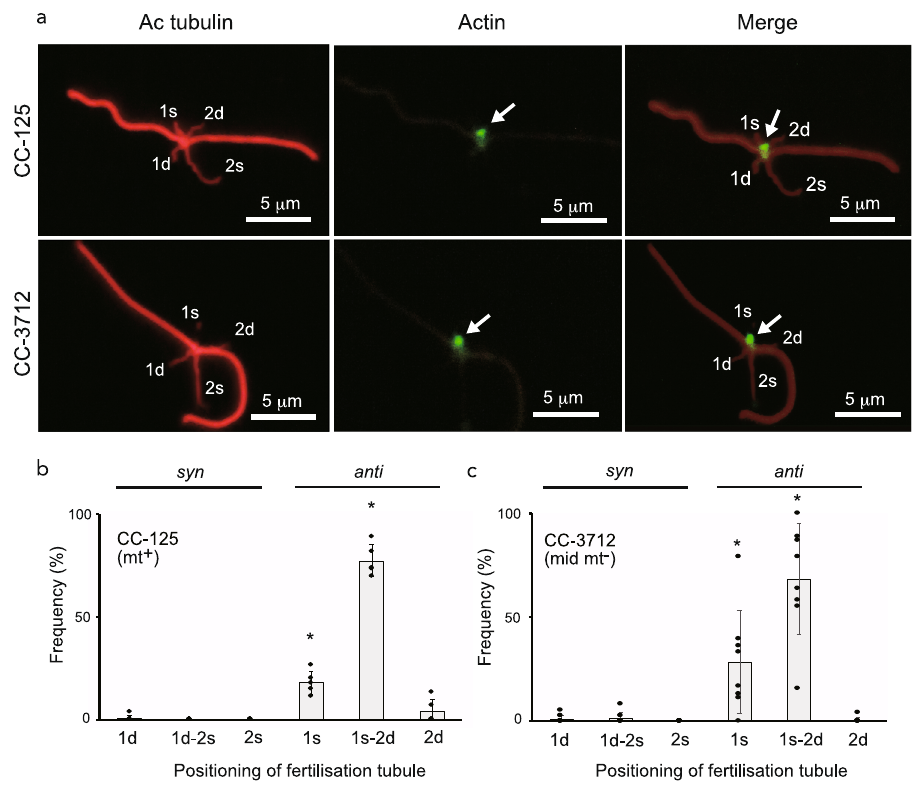
Fig. 3 Positioning of the fertilisation tubule with respect to the fl agellar beat plane and four microtubular roots in the wild-type CC-125 (mt + ) and mating type-reversed strain CC-3712 (mid mt – ). a Immuno fl uorescence staining of wild-type CC-125 (mt + ) and mating type-reversed strain CC-3712 (mid mt – ) gametes. Cells were stained with an anti-acetylated tubulin antibody (Ac tubulin) and an anti-actin antibody. Arrows indicate fertilisation tubules. b, c Frequency of the positioning of the fertilisation tubule in the wild-type mt + ( b ) and mating type-reversed strain CC-3712 ( c ). Values are means of fi ve (CC-125) and eight (CC-3712) independent observations ( n = 15, 18, 19, 23 and 27 in CC-125; n = 9, 12, 18, 19, 22, 23, 24, and 38 in CC-3712). Bars indicate standard deviations. * p < 0.01 by Tukey ’ s test. 1d, 1s, 2d , and 2s : 1d, 1s, 2d and 2s microtubular roots, respectively. shows the planozygote 15 min after mixing wild-type (mt + ) and Table 1 Lengths of the four microtubular roots of CC-3947 gametes, in which two eyespots aligned on the same side of the cell in the same way as in the wild-type (mt + ) × wild-type (mt – ) pair (Fig. 4d, e). One eyespot occupied a position close to the cell fusion plane, whereas the other eyespot was far from the plane.